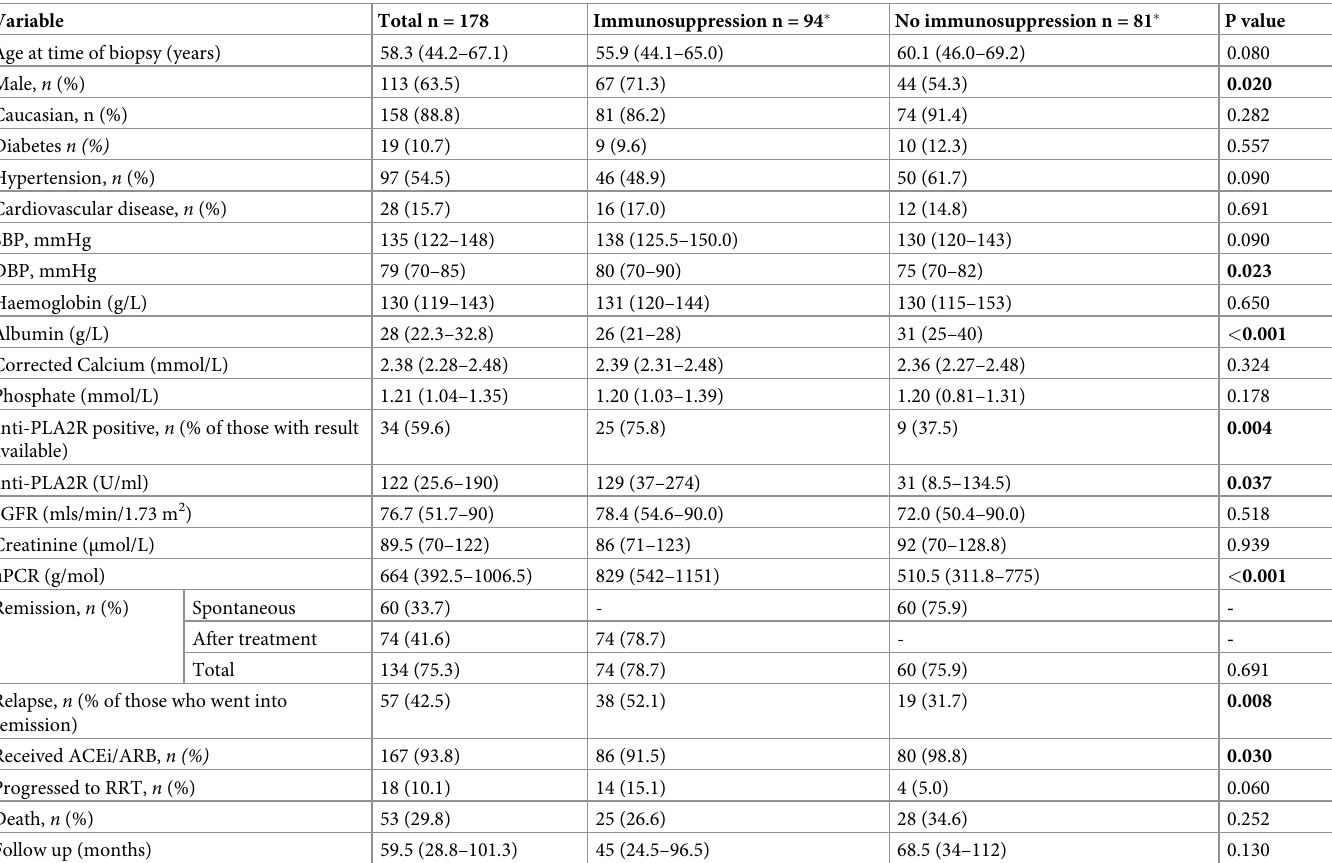
Table 1. Baseline characteristics and outcomes according to immunosuppression vs no